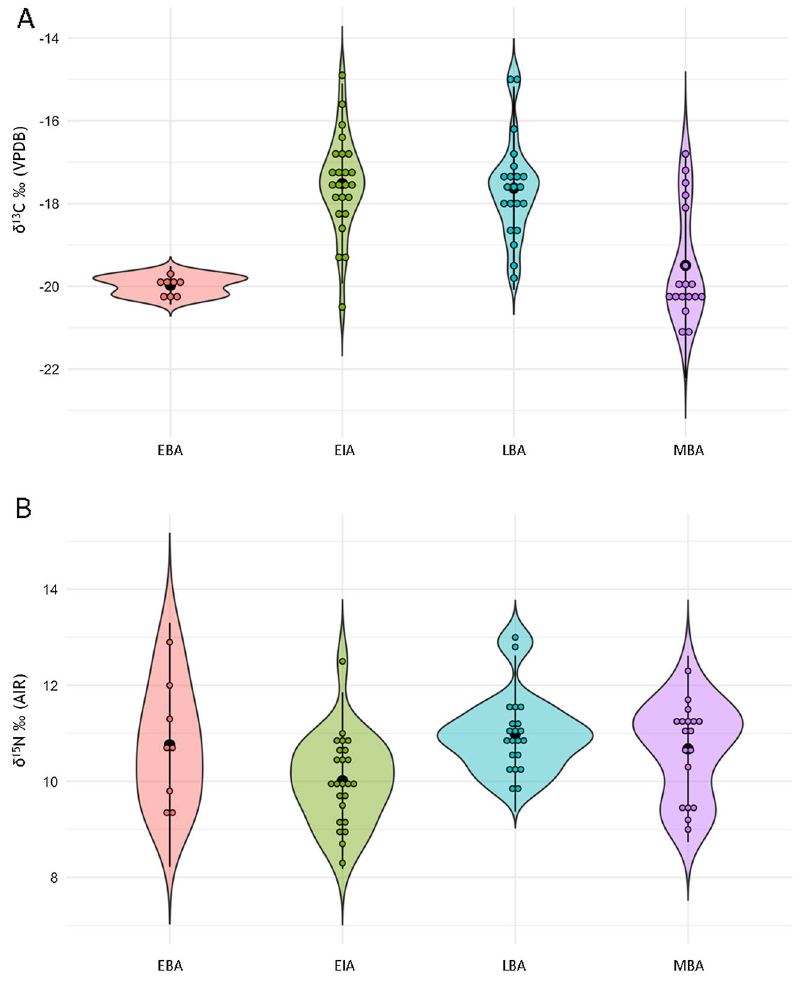
Figure 4. Violin plot of human ( A ) δ 13 C and ( B ) δ 15 N ratios by subperiod: Early Bronze Age (n = 8), Middle Bronze Age (n = 18), Late Bronze Age (n = 22), and Early Iron Age (n = 24). Center black dot represents mean; center black line represents distribution.